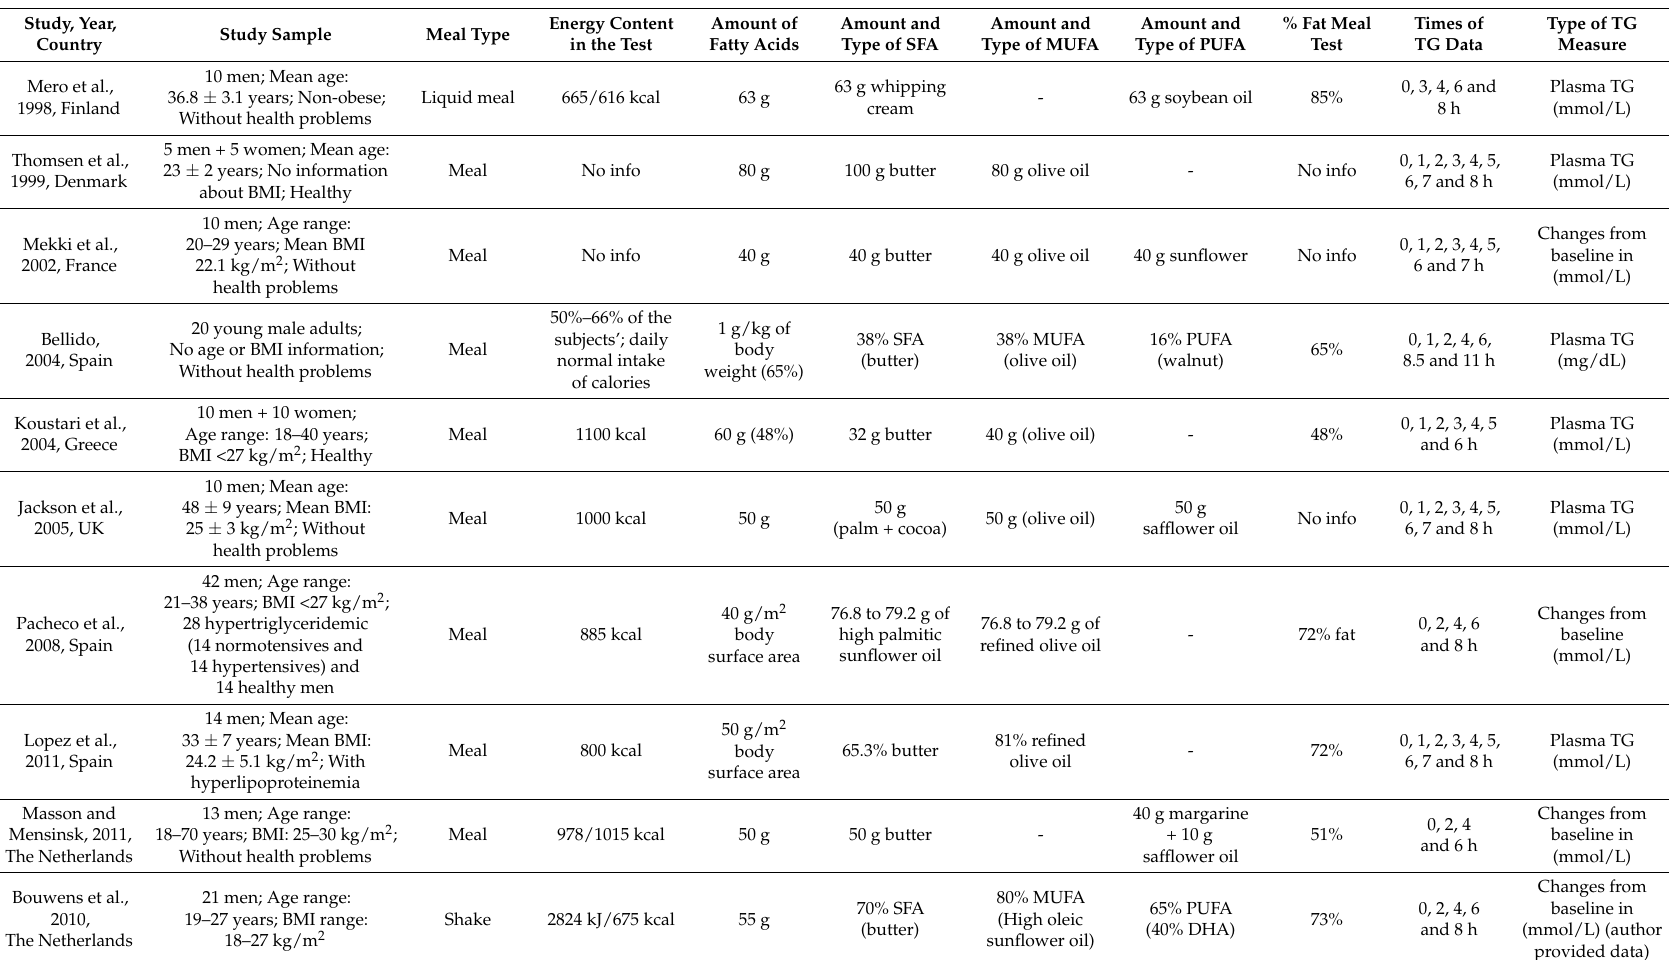
Table 1. Main characteristics of included studies in the